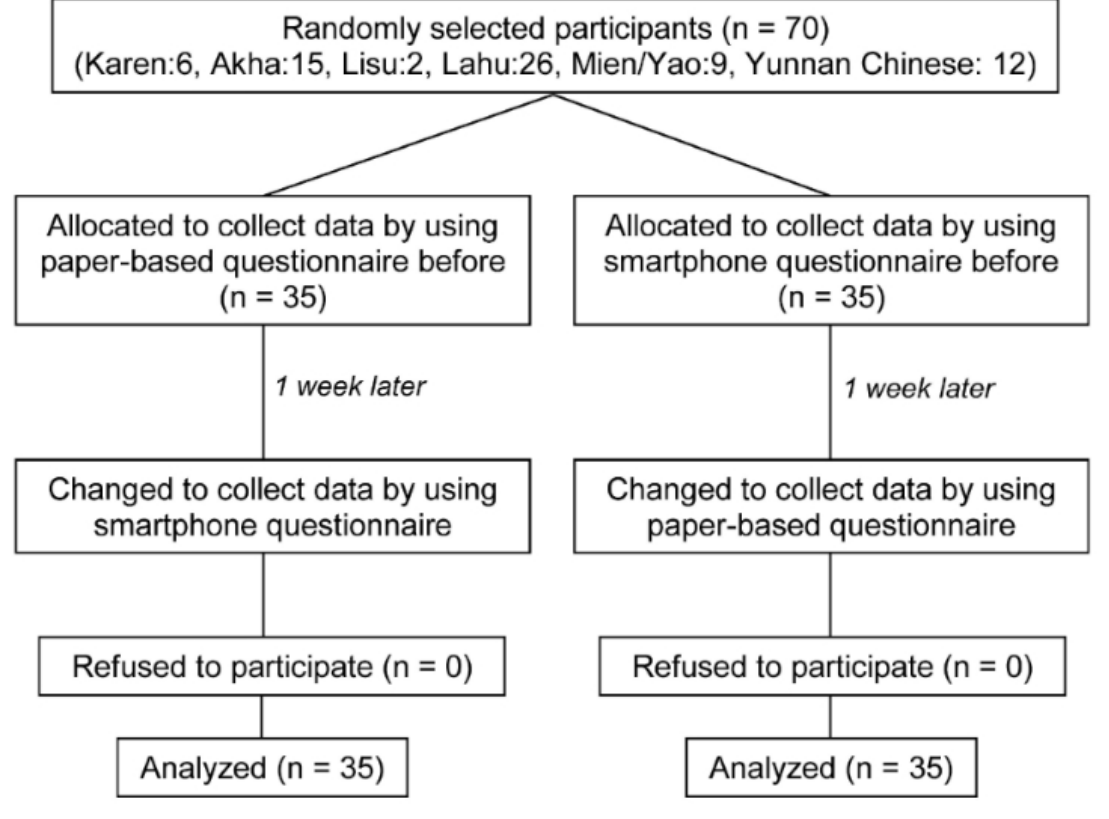
Figure 5. Workflow for data